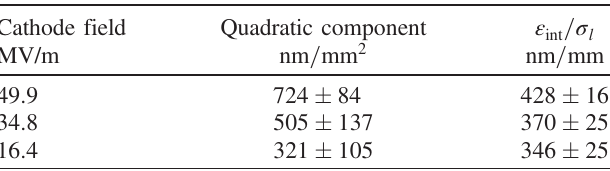
TABLE I. Reconstructed rf quadratic components and normal- ized intrinsic emittances as a function of the cathode field at the SwissFEL Injector Test